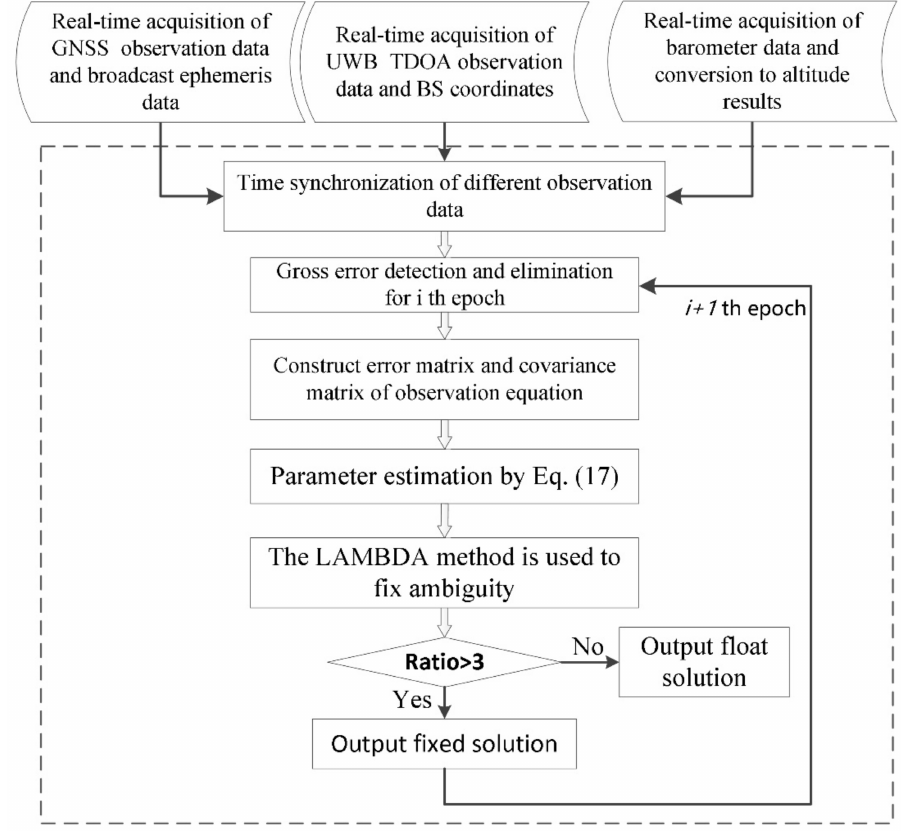
Figure 3. Flowchart of GNSS RTK/UWB/DBA tight combination data